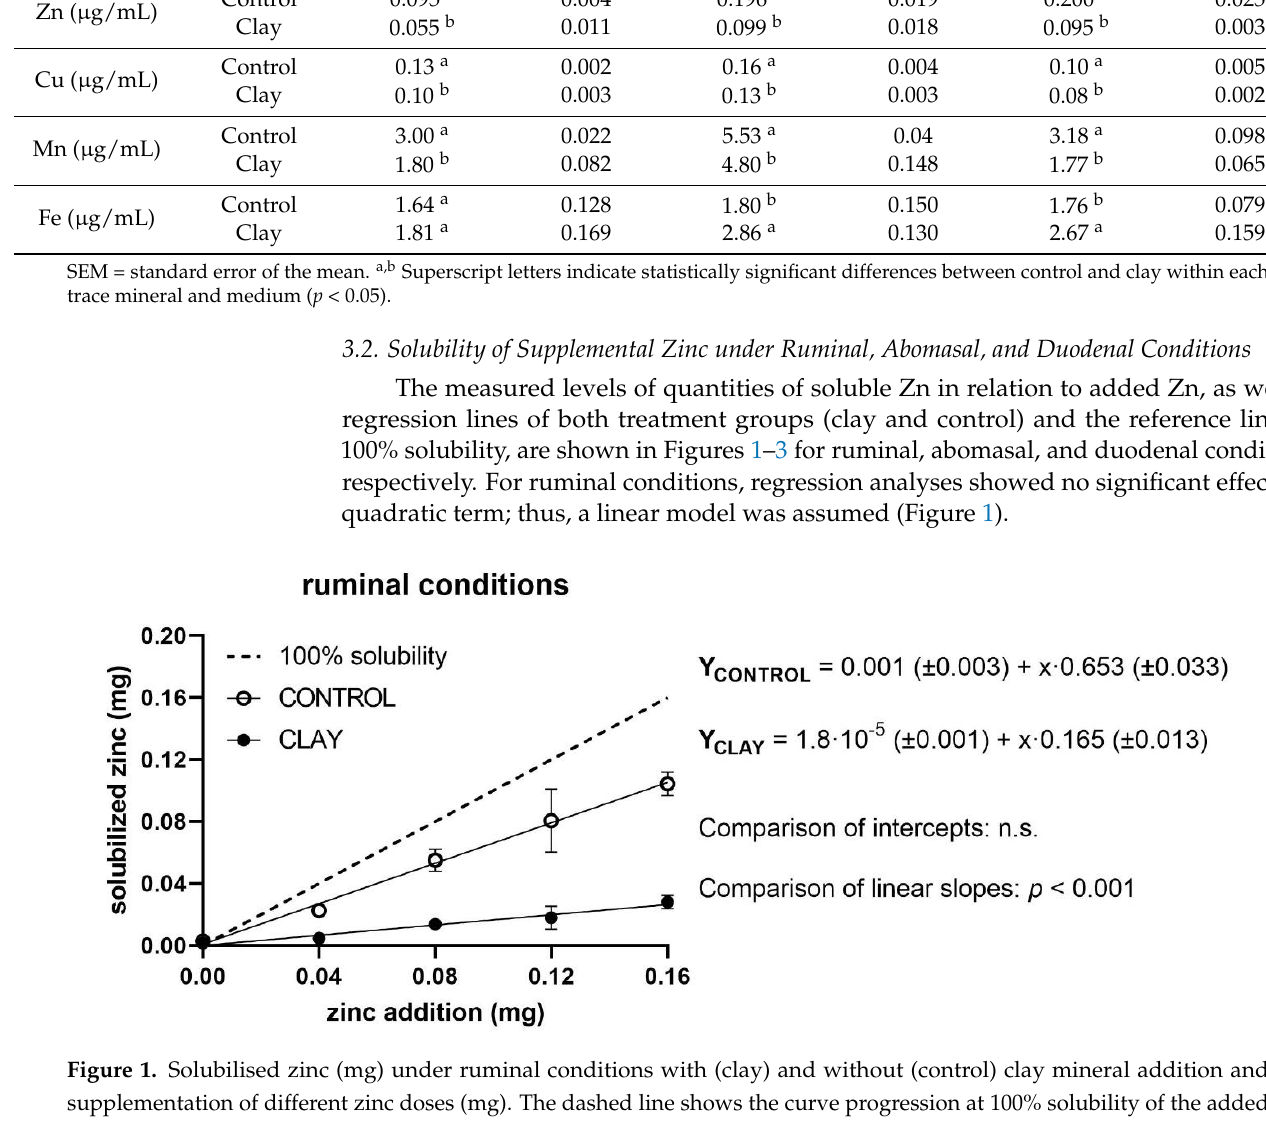
Table 3. Mean concentration ( µ g/mL) of dissolved trace elements in samples supplemented with (clay) and without (control) clay minerals under ruminal, abomasal, and duodenal conditions after 24 h incubation and initial pH value of digestive fluids. SEM = standard error of the mean. a,b Superscript letters indicate statistically significant differences between control and clay within each trace mineral and medium ( p < 0.05).